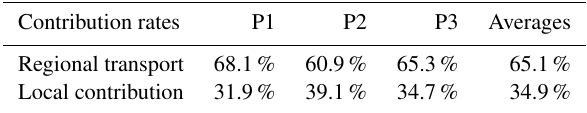
Table 4. The relative contributions of regional transport over CEC to three PM 2 . 5 heavy pollution periods, P1, P2, and P3, in the YRMB with local